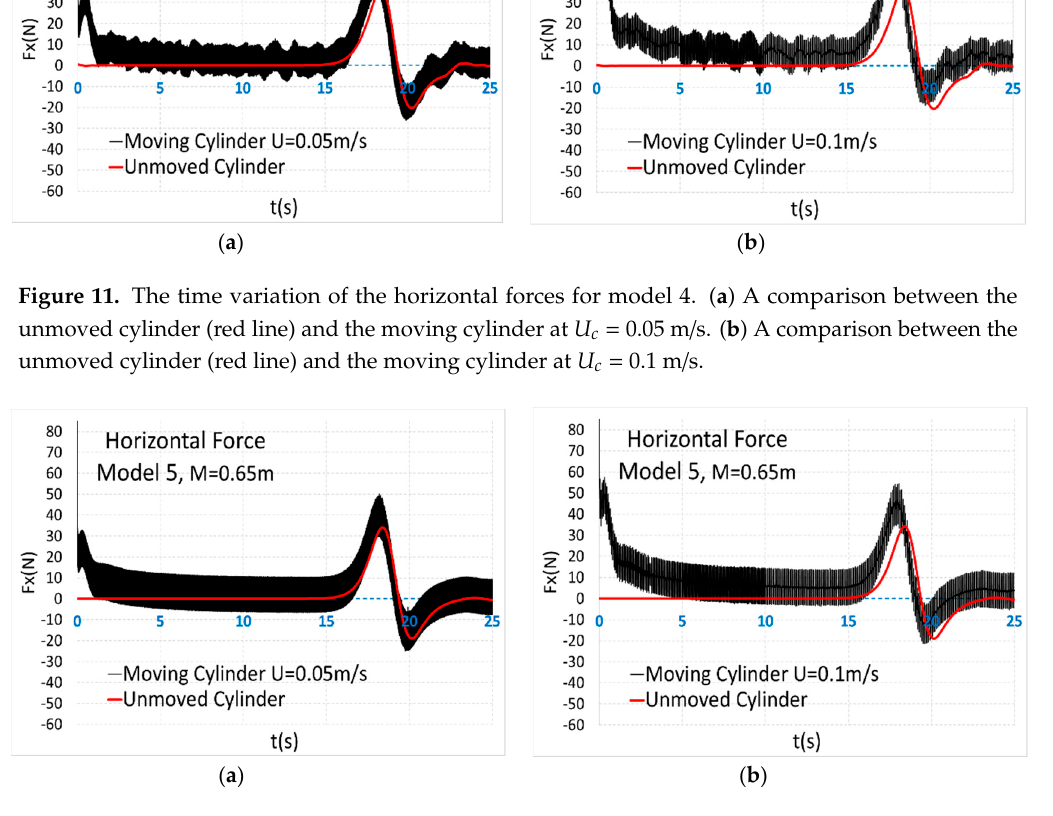
Figure 12. The time variation of the horizontal forces for model 5. ( a ) A comparison between the unmoved cylinder (red line) and the moving cylinder at U c = 0.05 m/s ( b ). A comparison between the unmoved cylinder (red line) and the moving cylinder at U c = 0.1 m/s.